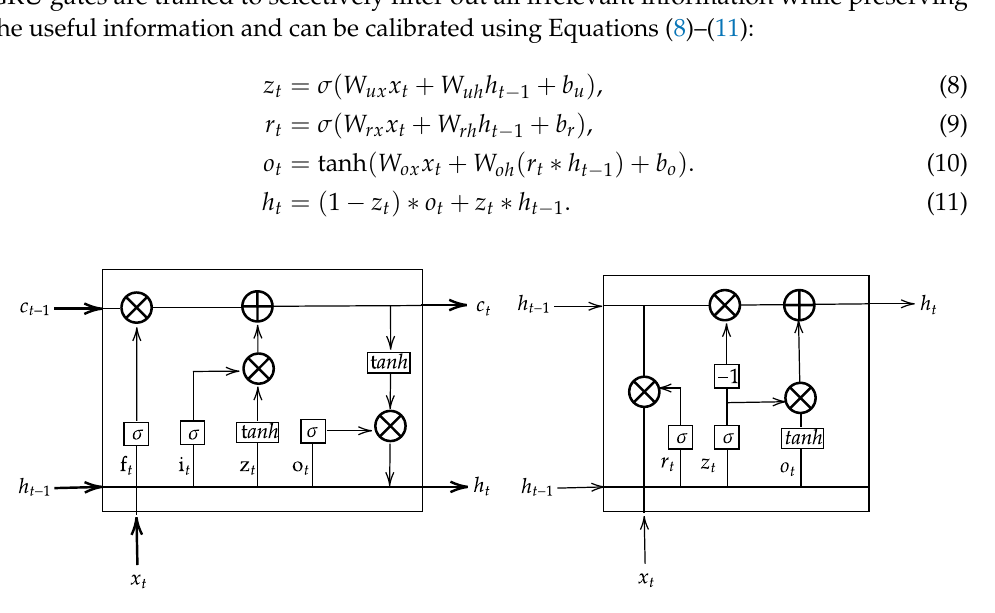
Figure 2. LSTM and GRU structures. Left side shows LSTM cell, right side shows GRU